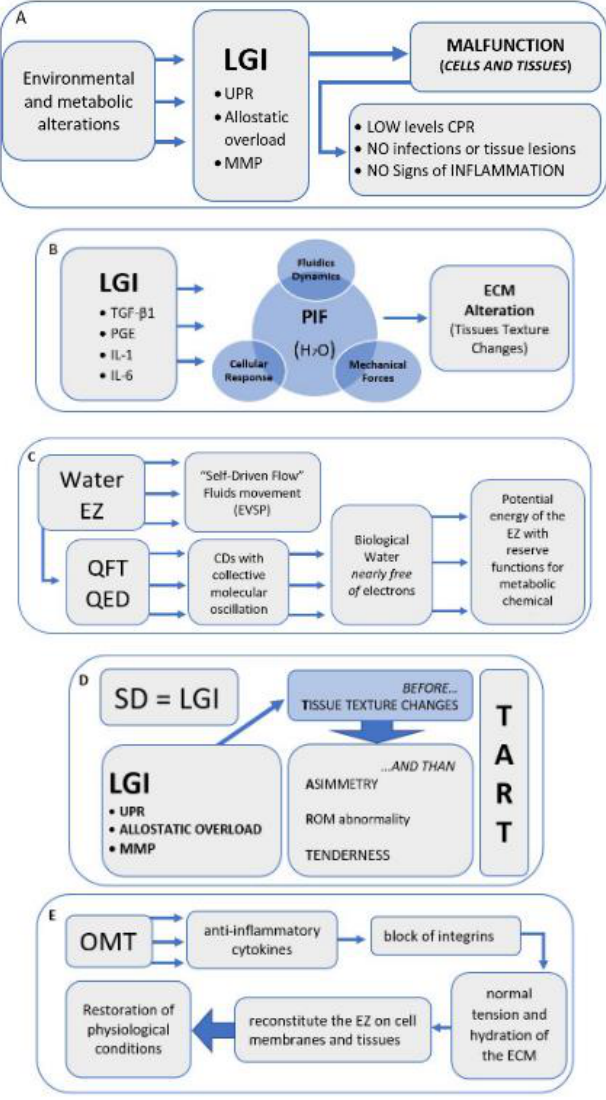
Figure 2. Narrative flow charts.